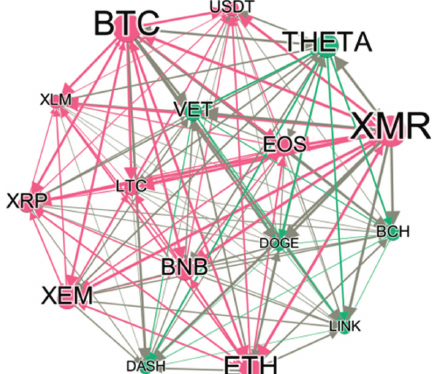
Figure 40: Risk spillover under E4.